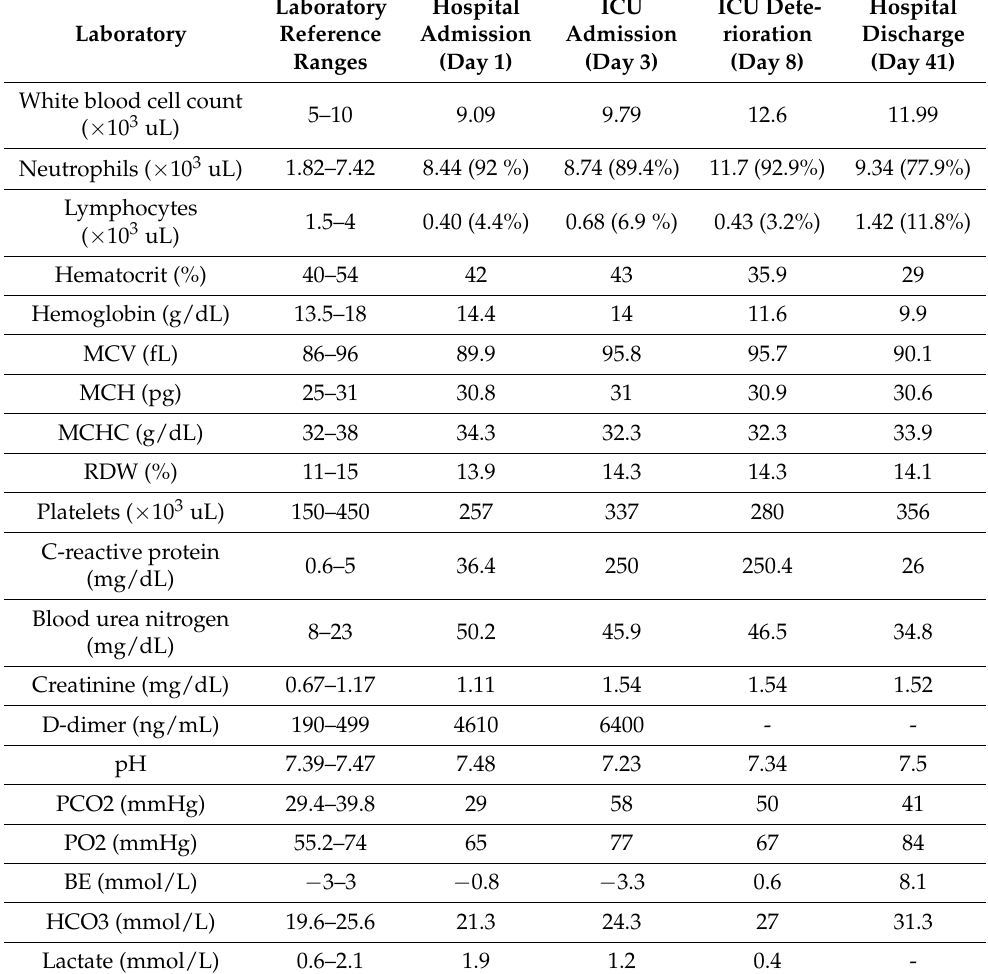
Table 1. Laboratory findings on admission and during